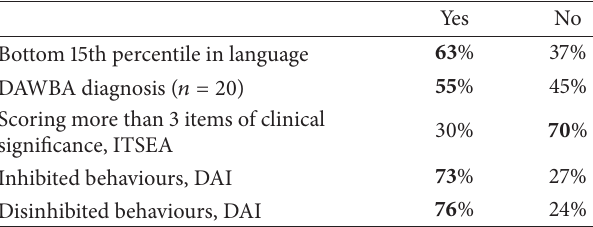
Table 6: Other problems experienced by children scoring in bottom 15th percentile in cognition ( 𝑛 = 30